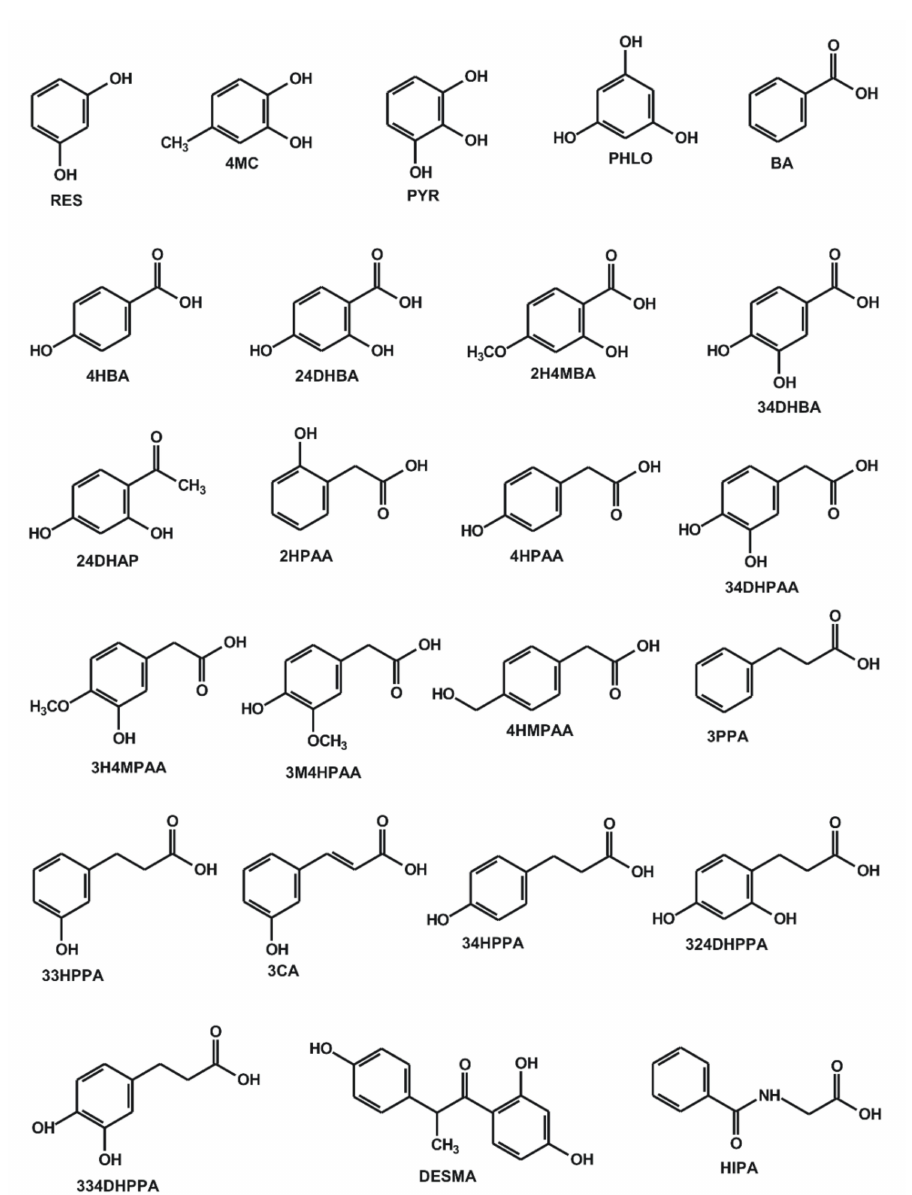
Figure 1. Chemical structures of resorcinol (RES), 4-methylcatechol (4MC), pyrogallol (PYR), phloroglucinol (PHLO), benzoic acid (BA), 4-hydroxybenzoic acid (4HBA), 2,4-dihydroxybenzoic acid (24DHBA), 2-hydroxy-4-methoxybenzoic acid (2H4MBA), 3,4-dihydroxybenzoic acid (34DHBA), 2,4-dihydroxyacetophenone (24DHAP), 2-hydroxyphenylacetic acid (2HPAA), 4-hydroxyphenylacetic acid (4HPAA), 3,4-dihydroxyphenylacetic acid (34DHPAA), 3-hydroxy-4-methoxyphenylacetic acid (3H4MPAA), 3-methoxy-4-hydroxyphenylacetic acid (3M4HPAA), 4-(hydroxymethyl)phenylacetic acid (4HMPAA), 3-phenylpropionic acid (3PPA), 3-(3-hydroxyphenyl)propionic acid (33HPPA), 3-coumaric acid (3CA), 3-(4-hydroxyphenyl)propionic acid (34HPPA), 3-(2,4-dihydroxyphenyl)propionic acid (324DHPAA), 3-(3,4-dihydroxyphenyl)propionic acid (334DHPPA), O -desmethylangolensin (DESMA), and hippuric acid